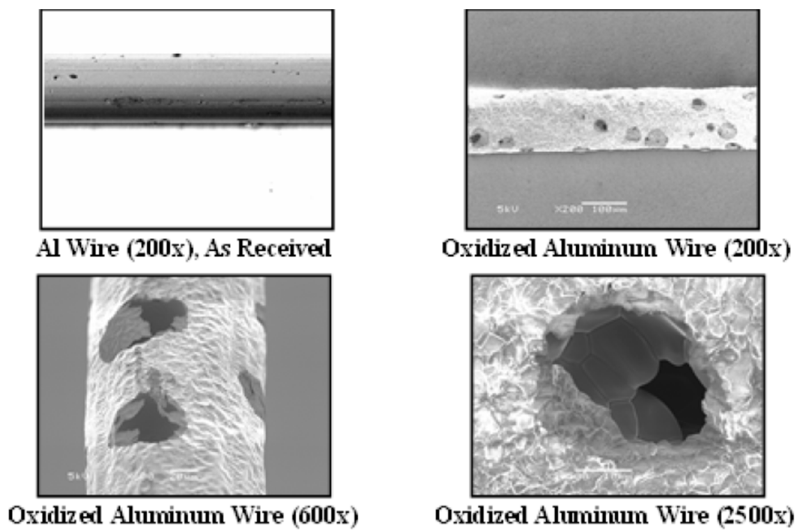
Figure 21. Illustration of damage due to localized heating apparently caused by silica inclusions in the wire.